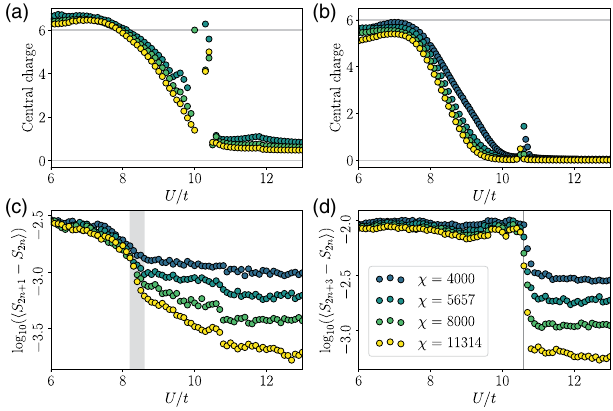
FIG. 5. Entanglement results for the YC4 cylinder. (a) Central charge of the effective one-dimensional state as calculated by the scaling of entanglement with correlation length, Eq. (3); this is the most accurate method for gapless systems. (b) Central charge as calculated by the scaling of entanglement with bond dimen- sion, Eq. (4); this is the most accurate method for gapped systems. (c) Average separation between pairs of levels from the entan- glement spectrum; the shaded region is U=t ¼ 8 . 2 – 8 . 6 , where the spectrum approaches exact twofold degeneracy with increasing bond dimension. (d) Average separation among groups of four levels from the spectrum; the vertical line at U=t ¼ 10 . 6 marks the onset of fourfold